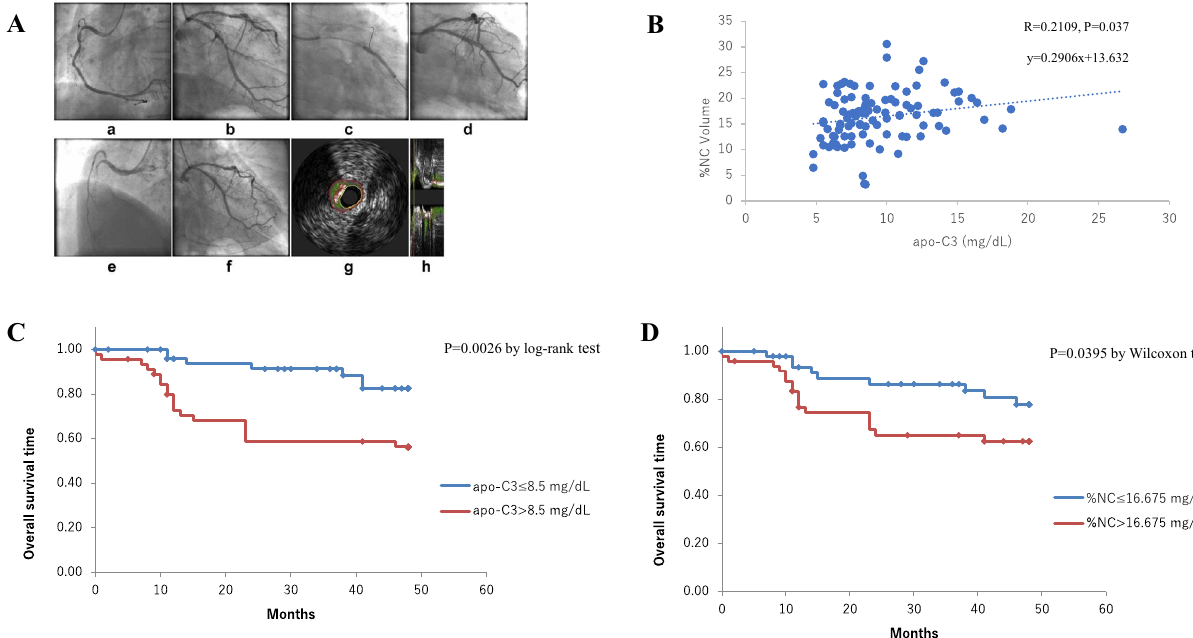
Figure 1. Representative case in the high apo-C3 group ( A ) Coronary angiograms of a representative case (a male patient) and virtual histology-intravascular ultrasound (VH-IVUS) of the lesion. ( a ) An intermediate lesion in the proximal right coronary artery at pre-percutaneous coronary intervention (PCI). ( b ) The target severe stenotic tandem lesion in the left circumflex coronary artery (LCX). ( c ) Two drug-eluting stents were implanted. ( d ) Coronary angiography findings after stenting. ( e , f ) Eight months later, the patient experienced acute myocardial infarction and was transported to our hospital by ambulance; coronary angiography was immediately performed. ( e ) The mid-right coronary artery, which had an intermediate lesion before PCI, was completely occluded. ( f ) The LCX showed no restenosis. ( g ) The VH-IVUS cross-sectional image of the lesion that underwent PCI in the LCX. ( h ) The longitudinal VH-IVUS image of the same lesion. In the color image, green indicates the fibrous region; yellowish green, the fibrofatty region; red, the necrotic core; and white, dense calcium. In this patient, the percentage necrotic core volume was 22.43%, and the apolipoprotein C3 level was 8.8 mg/dL. ( B ) Correlation curve between apo-C3 and %NC volume. There was a significant correlation between apo-C3 and %NC volume ( P = 0.037). ( C ) Kaplan–Meier curves between patients with high apo-C3 and those with low apo-C3. Kaplan–Meier curves indicated that patients with high apo-C3 levels (> 8.5 mg/dL) had significantly lower freedom from MACEs than those with lower apo-C3 levels (≤ 8.5 mg/dL) ( P < 0.001). ( D ) Kaplan–Meier curves between patients with high %NC and those with low %NC. Kaplan–Meier curves indicated that patients with high %NC (> median value = 16.675%) had significantly lower freedom from MACEs than did those with low %NC (≤ median value = 16.675%) ( P < with high %NC was 35.6 ± 2.5 (95% CI 30.6–40.5) months, while that with low %NC was 42.8 ± 1.8 (95% CI 39.2–46.3) months. Cox proportional hazards regression model for 4 year MACEs. In the univariate analysis, the %NC (hazard ratio [HR], 1.1207; 95% CI 1.0337–1.2151; P = 0.0057), %DC (HR, 1.1454; 95% CI 1.0482–1.2581; P = 0.0046), and high apo-C3 (HR, 3.4977; 95% CI 1.4696–8.3258; P = 0.0047) were significant risk factors for 4 year MACEs. Moreover, the multivariate analysis showed that the %NC (HR, 1.0960; 95% CI 1.0099–1.1894; P = 0.028) and high apo-C3 (HR, 2.9381; 95% CI: 1.2106–7.0820; P = 0.0171) were strong predictors of 4 year MACEs (Table 4). Additionally, a multivariate Cox hazards analysis adjusted for LDL-C and apo-B (model 1) showed that the %NC (HR, 1.1025; 95% CI 1.0157–1.1967; P = 0.0197) and high apo-C3 (HR, 2.6498; 95% CI 1.0465–6.7096; P = 0.0398) could predict 4 year MACEs. Similarly, in a model adjusted for apo-A1 and estimated glomerular filtration rate (eGFR) (model 2), %NC (HR, 1.1021; 95% CI 1.0127–1.1994; P = 0.0243) and high apo-C3 (HR, 2.9415; 95% CI 1.2163–7.1139; P = 0.0166) were independent predictors of 4 year MACEs (Table 5). Comparison of VH-IVUS data between the new lesion plaque after PCI and the angiographical non-stenotic lesion plaque of his own pre-first PCI.